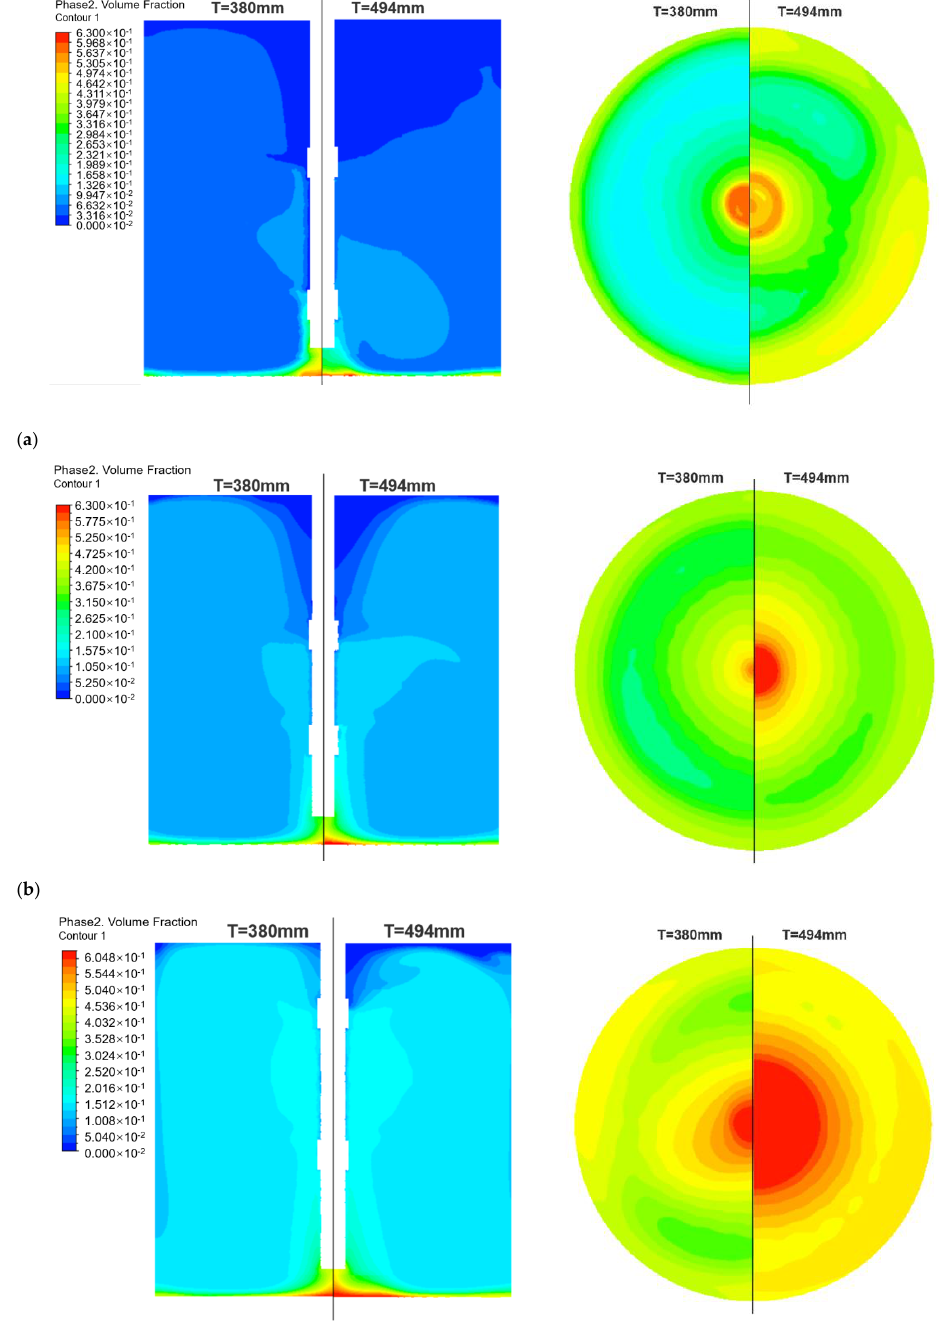
Figure 8. Comparison of solid concentration distributions scaled up based on the same Reynolds number: ( a ) Co = 5% v/v ; ( b ) Co = 10% v/v ; ( c ) Co = 15% v/v . Table 6 records the solid uniformity σ of the tanks before and after scaling up, ac- cording to the same Reynolds number criterion under different solid content. It can easily be seen from Table 6 that there was a large gap in the σ values before and after scaling up under the three solid content conditions, also confirming the conclusion reached before. Table 6. The solid uniformity σ before and after scaling up based on the same Reynolds number.